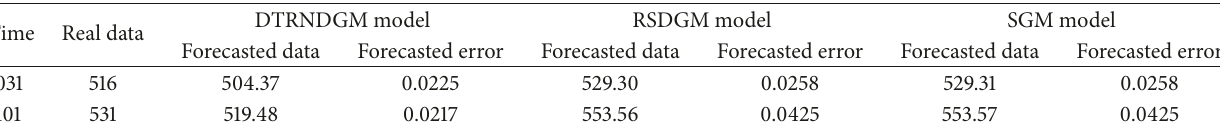
Table 6: Simulated or forecasted values and errors of traffic flow with the 𝜒 ∈ 𝑅 3×7×24×3